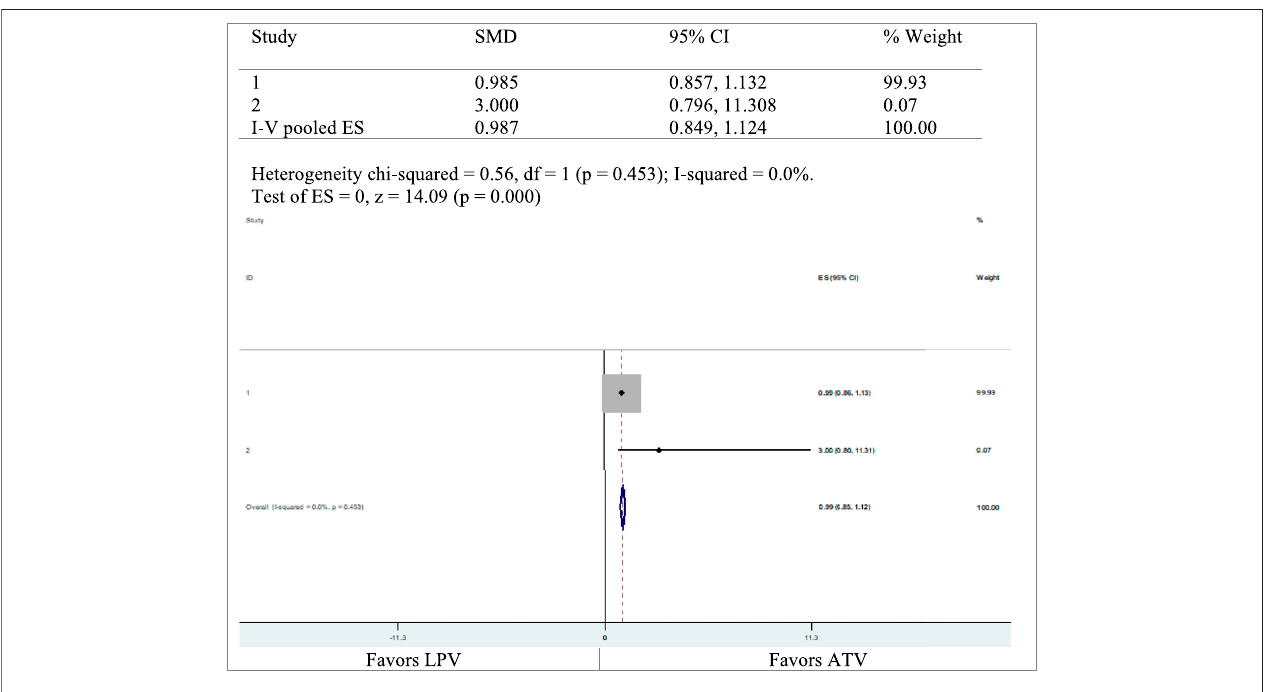
FIGURE 4 | Adverse events of ATV and